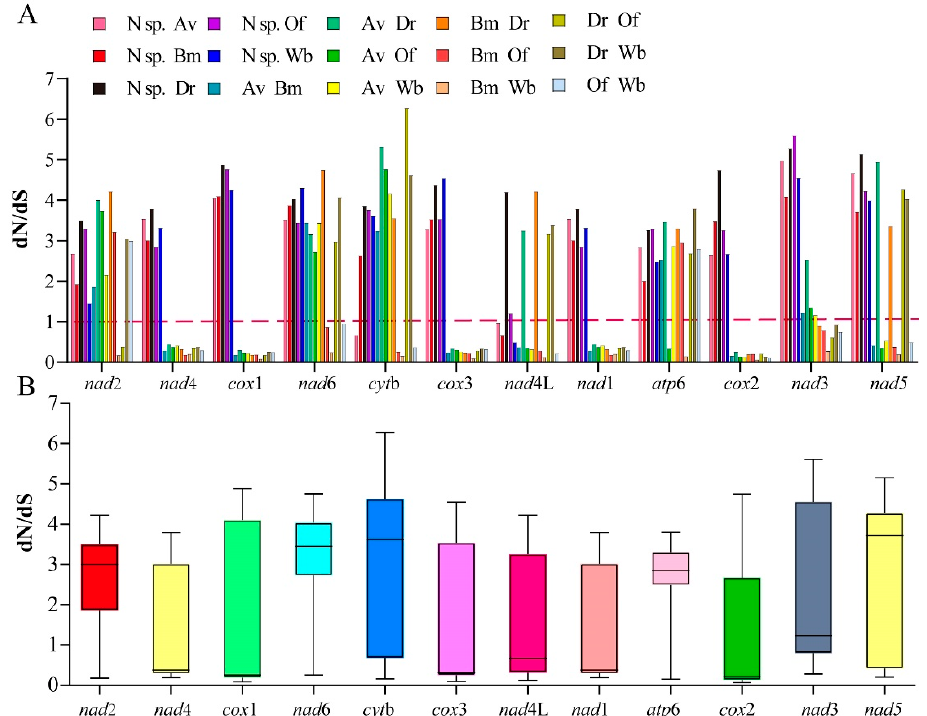
Figure 4. Ratio of the rates of non-synonymous ( dN ) to synonymous ( dS ) nucleotide substitutions ( dN/dS ). ( A ) Bar graph of the pairwise ratios of dN/dS for each of the mitochondrial subunits of the investigated species. ( B ) Box chart illustrating the average pairwise ratios of dN/dS for each of the mitochondrial subunits of the investigated species. The dN/dS ratios are plotted on the y-axis, and the PCGs are plotted on the x-axis.